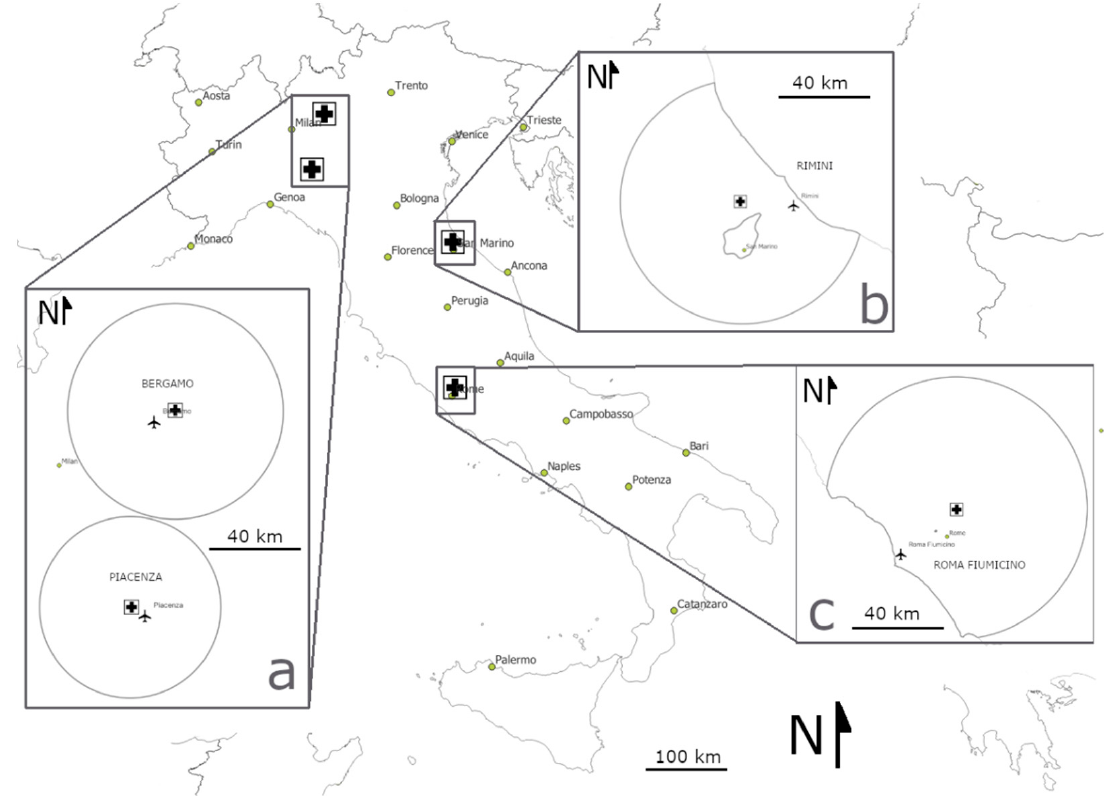
Figure 1. Geographical locations of the four Italian bat rehabilitation centres (indicated by crosses) and nearby airports (depicted by aeroplane icons) where temperature data were obtained. The circles indicate the primary geographic areas served by each rehabilitation centre (data provided by the respective centres). The letters identify the geographic areas where centres and airports are located. ( a ): Berga-mo-Valpredina and Piacenza; ( b ): Rimini and ( c ):